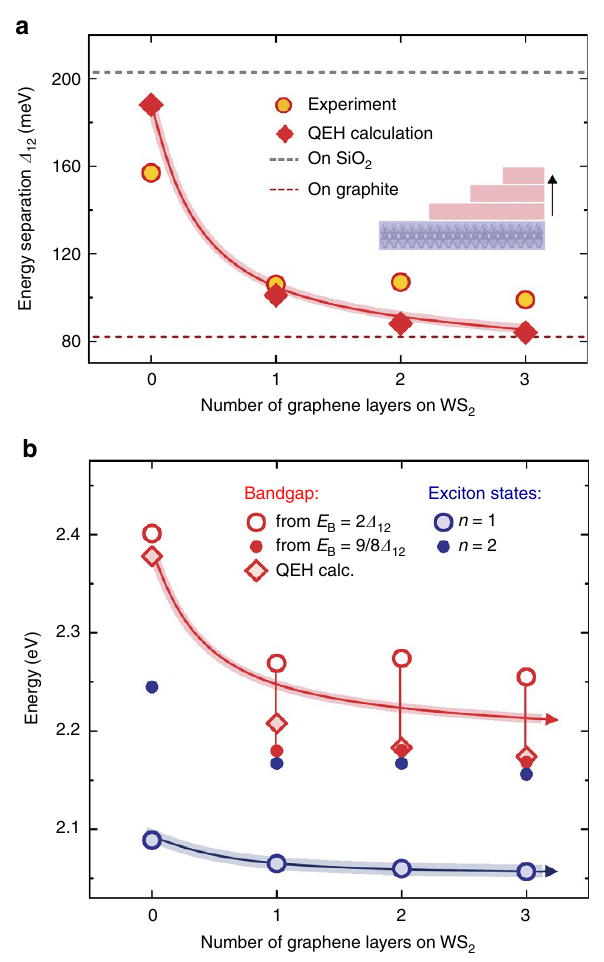
Figure 2 | Out-of-plane spatial sensitivity of environmental screening. ( a ) Experimentally and theoretically obtained energy separation D 12 between the n ¼ 1 and n ¼ 2 exciton states as a function of the number of layers of capping graphene. Dashed lines indicate D 12 values from the solution of the electrostatic model for uncapped WS 2 supported by fused silica substrate (grey) and covered with bulk graphite (red), representing two ideal limiting cases. ( b ) Absolute energies of the experimentally measured exciton ground state ( n ¼ 1) and the first excited state ( n ¼ 2) resonances, as well as the estimated positions of the bandgap obtained by adding the exciton binding energy to the energy of the n ¼ 1 state. The binding energy scales with D 12 , where the limiting cases are an experimentally determined non-hydrogenic scaling for WS 2 on SiO 2 substrate from ref. 24 E B ¼ 2 D 12 ð Þ and the 2D-hydrogen model in a homogeneous dielectric E B ¼ 9 = 8 D 12 ð Þ . These are compared to the bandgap energies deduced from the calculated exciton binding energies using the QEH model. The solid lines are guides to the